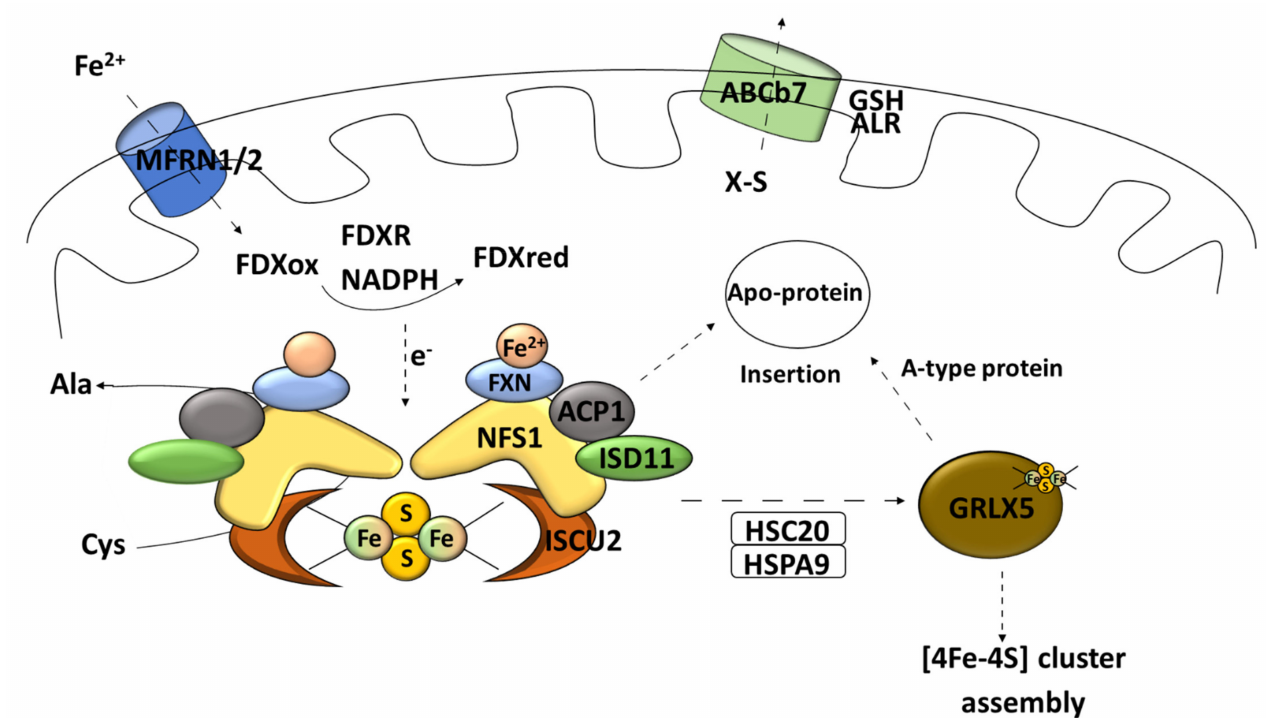
Figure 3. Early stage of mitochondrial Fe–S synthesis. NFS1, cysteine desulfurase; ISD11, LYR protein; ACP1, acyl carrier protein; ISCU2, scaffold protein; MFRN1/2, carrier protein mitoferrin 1 and 2; FXN, frataxin; FDXR, mitochondrial ferredoxin reductase; Cys, L-cysteine; Ala, L-alanine; HSPA9, mortalin/mitochondrial 70 kDa heat shock protein; HSC20, iron–sulfur cluster co-chaperone protein HscB; GLRX5, monothiol glutaredoxin 5; GSH, reduced glutathione; ALR, mitochondrial FAD-linked sulfhydryl oxidase; ABCb7, ATP-binding cassette (ABC) transporter